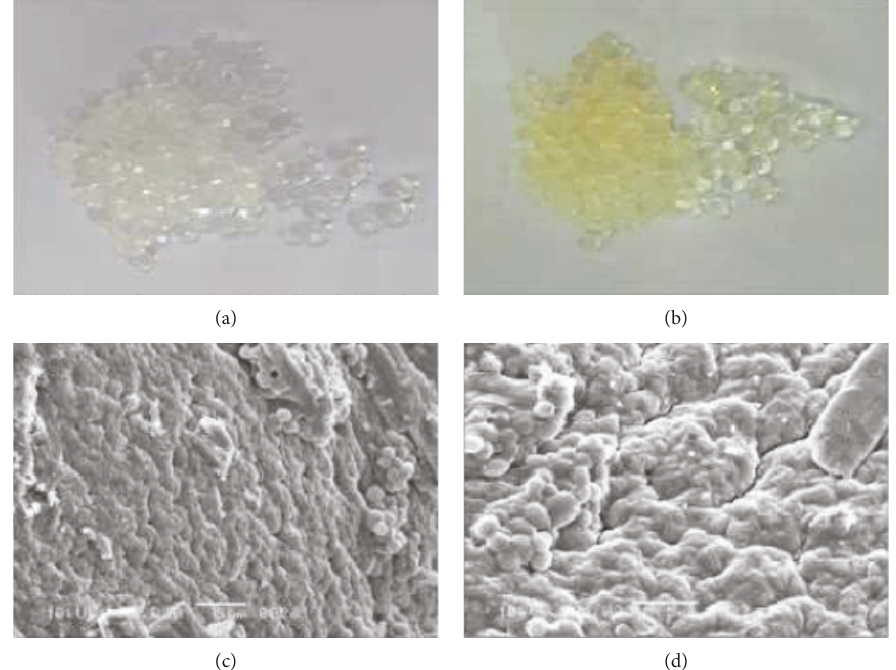
Figure 2: Calcium alginate spheres and scanning electron microscopic analysis: (a, c) alginate spheres without dextranase and (b, d) alginate spheres with entrapped